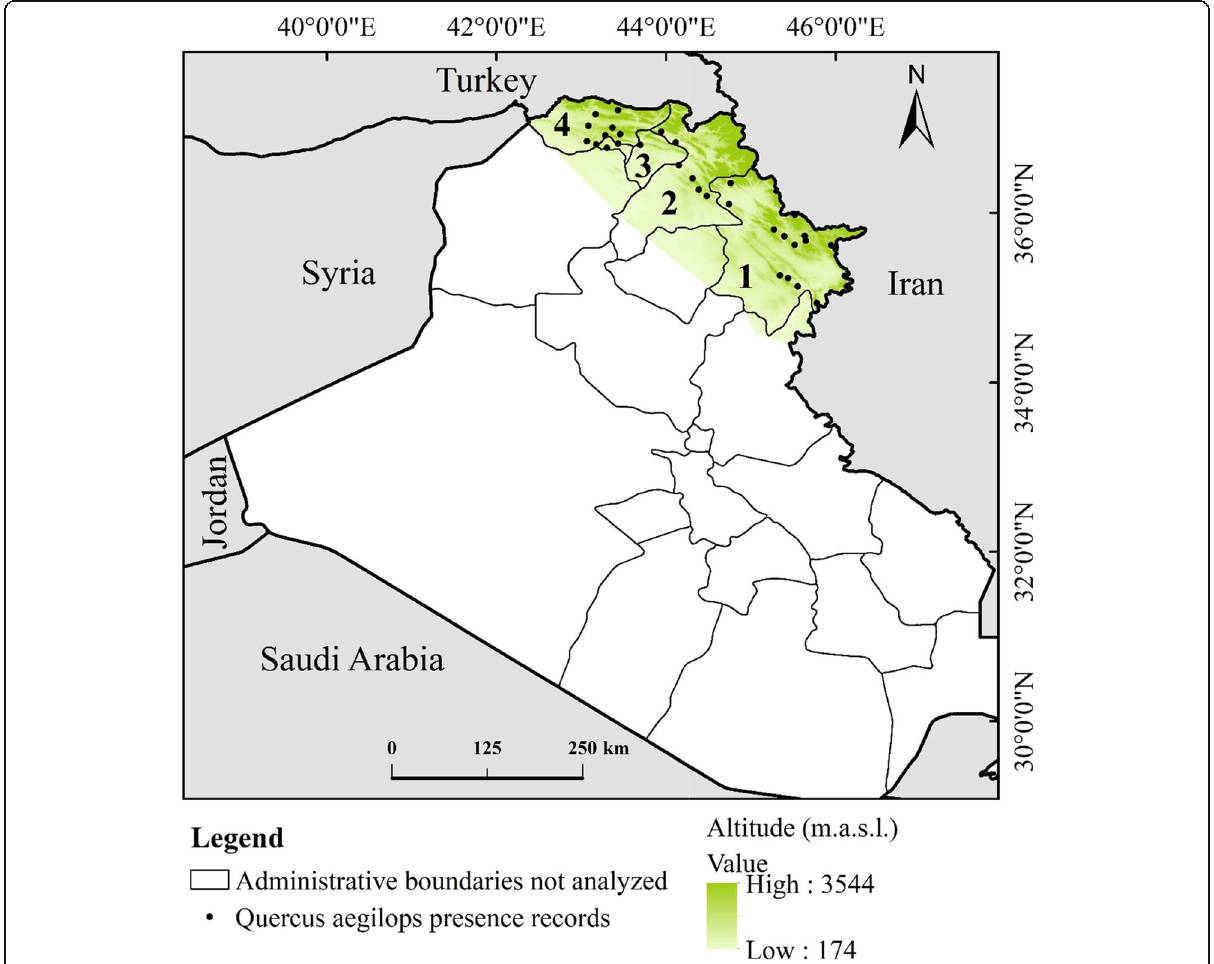
Fig. 1 Extent of the study site and administrative boundaries analyzed (1 = Sulaimani Province; 2 = Erbil Province; 3, 4 = Duhok Province (including Shexan and Akre